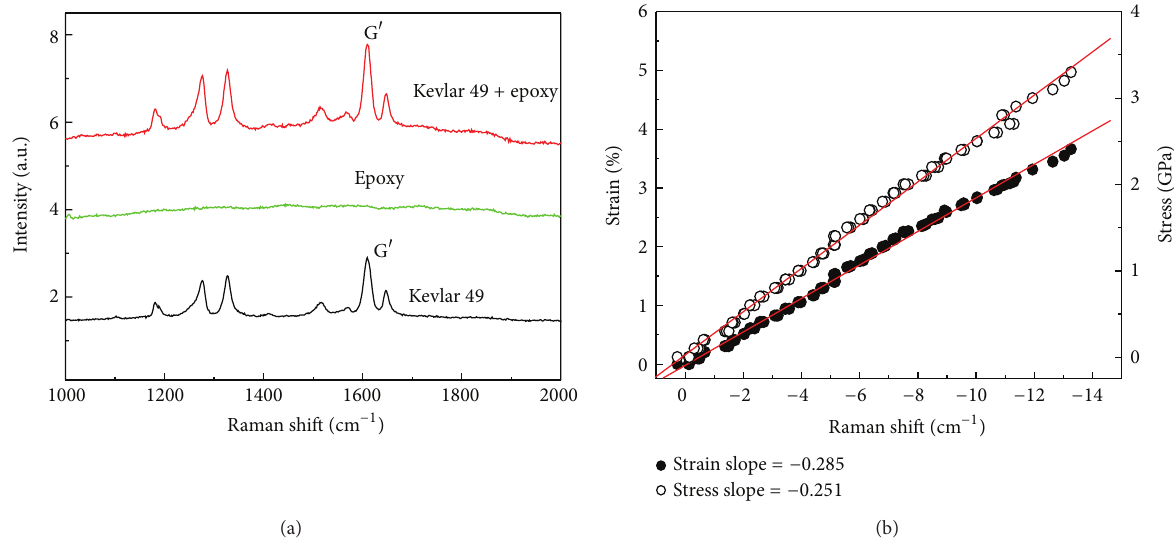
Figure 4: Raman spectra of (a) fiber/epoxy droplet specimen compared with pure epoxy and Kevlar 49 fiber [14] and (b) relationships of Raman shift with stress and strain for Kevlar 49 fiber